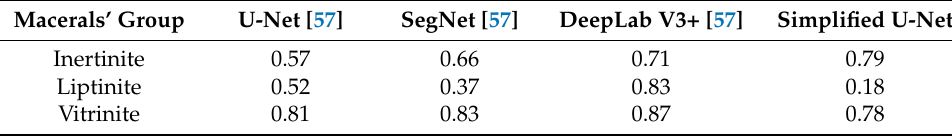
Table 4. The IoU values obtained for various deep networks